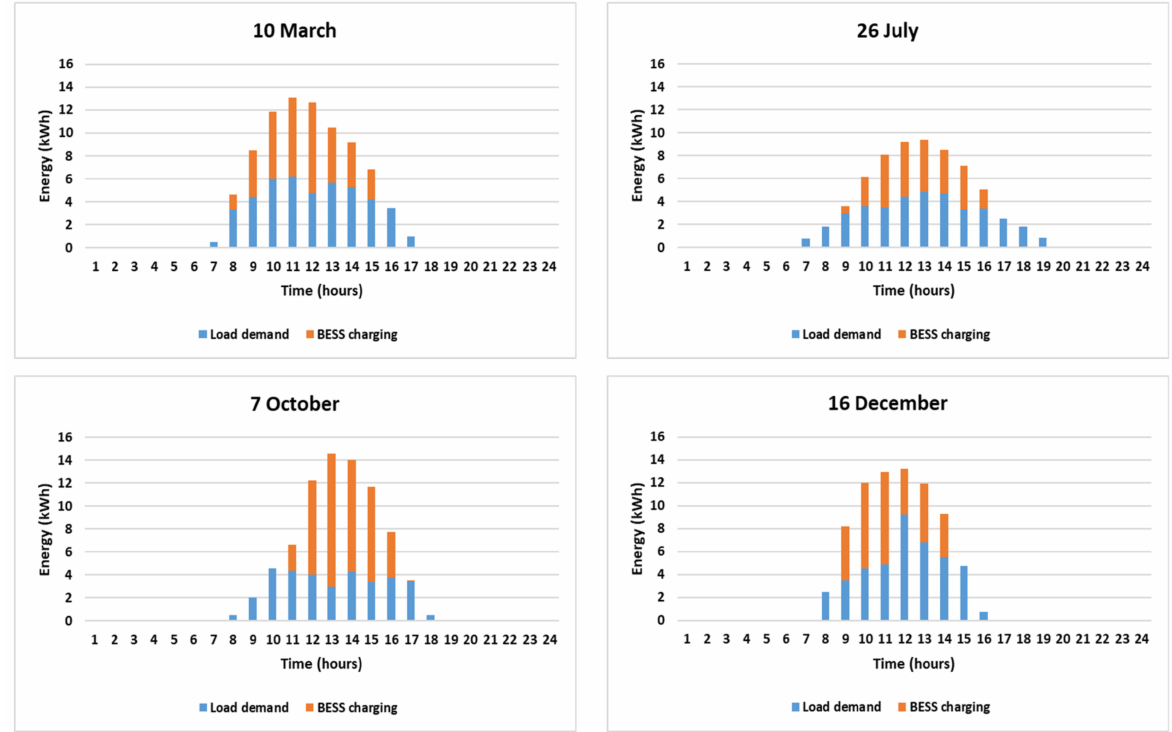
Figure 5. Distribution of PV production of each simulated day.